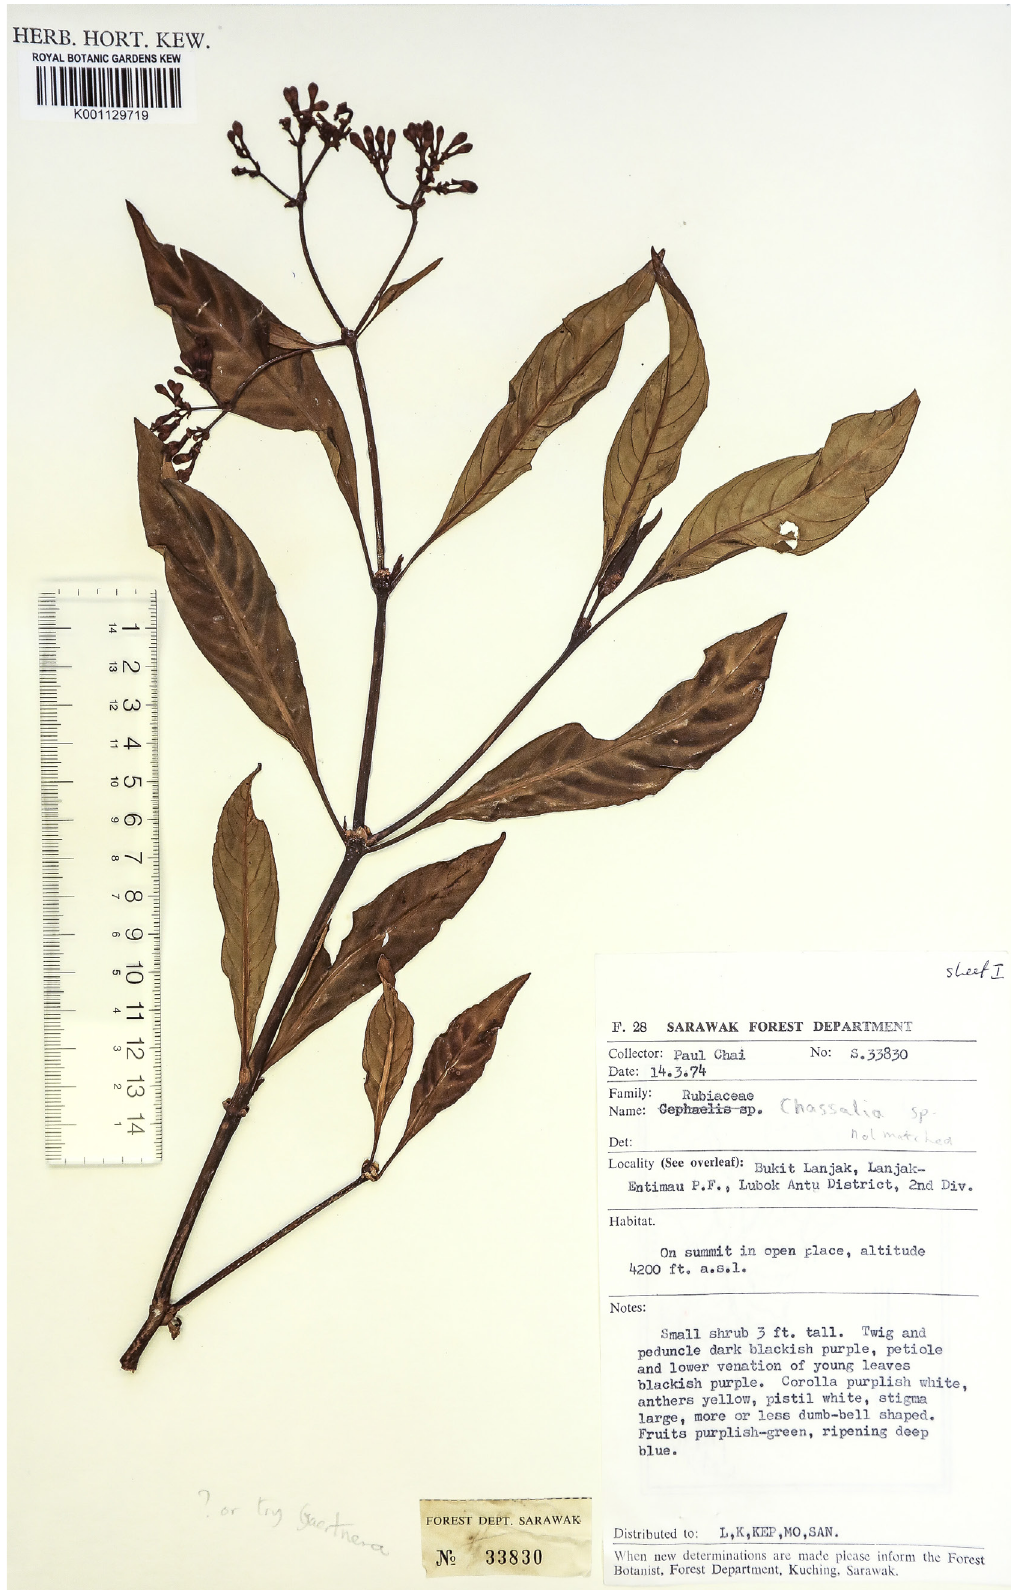
Fig. 5. Part of holotype of Chassalia atropurpurea T.Y.Yu sp. nov. ( Paul Chai S 33830 ); sheet 1 of